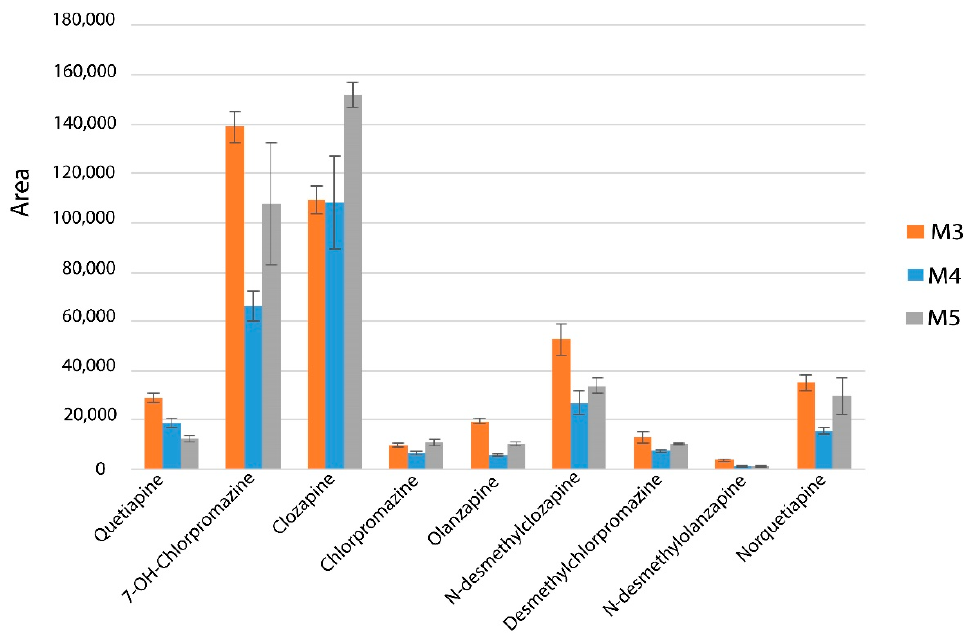
Figure 2. The e ff ect of di ff erent synthesis procedures on the performance of in-tube SPME-MS / MS Figure 2. The effect of different synthesis procedures on the performance of in ‐ tube SPME ‐ MS/MS method (Table 1 describes the synthesis conditions). method (Table 1 describes the synthesis conditions).